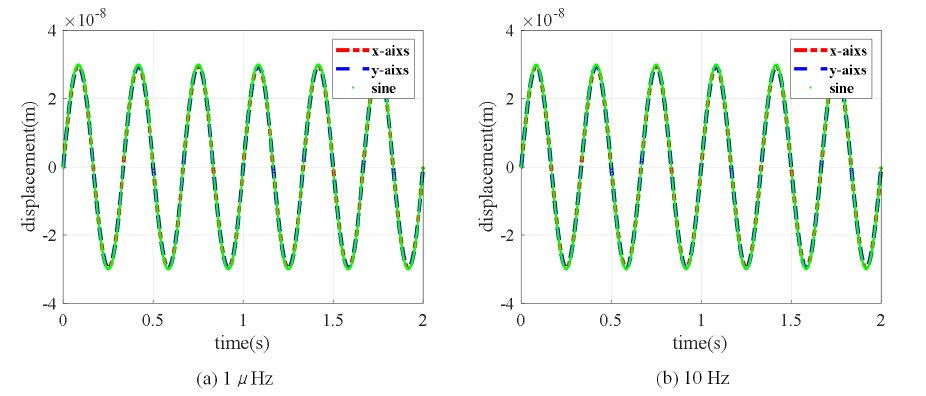
Figure 12. Tracking of electrostatic suspension with disturbance of ( a ) 1 µ Hz and ( b ) 10